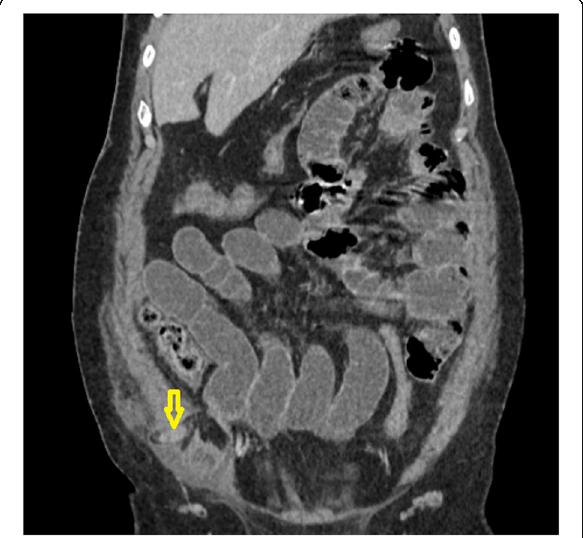
Fig. 2 Coronal CT with IV contrast the inflamed appendix (yellow arrow) passing through the hernia defect. Noted fat stranding and rim of fluid collection surrounding the